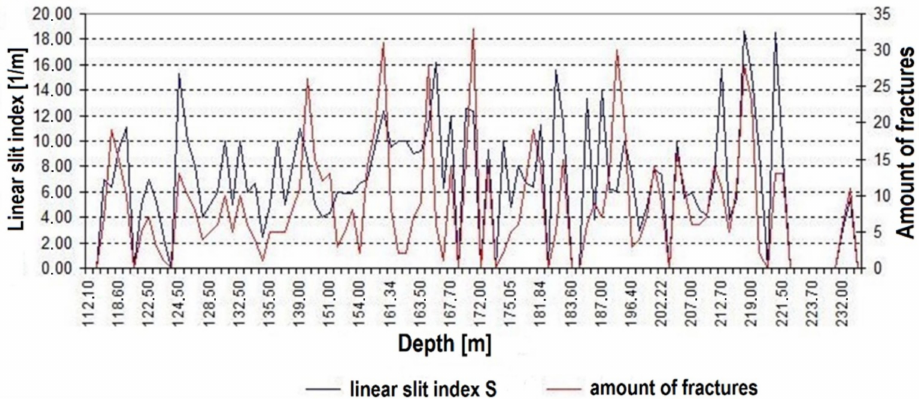
Figure 3. Graph of the average fracture amount per meter in Triassic formation in the borehole A. Groundwater was also sampled in borehole A on different levels. The analysis of sam- ples confirmed a phenomenon of rising groundwater mineralization with depth (Figure 4.).